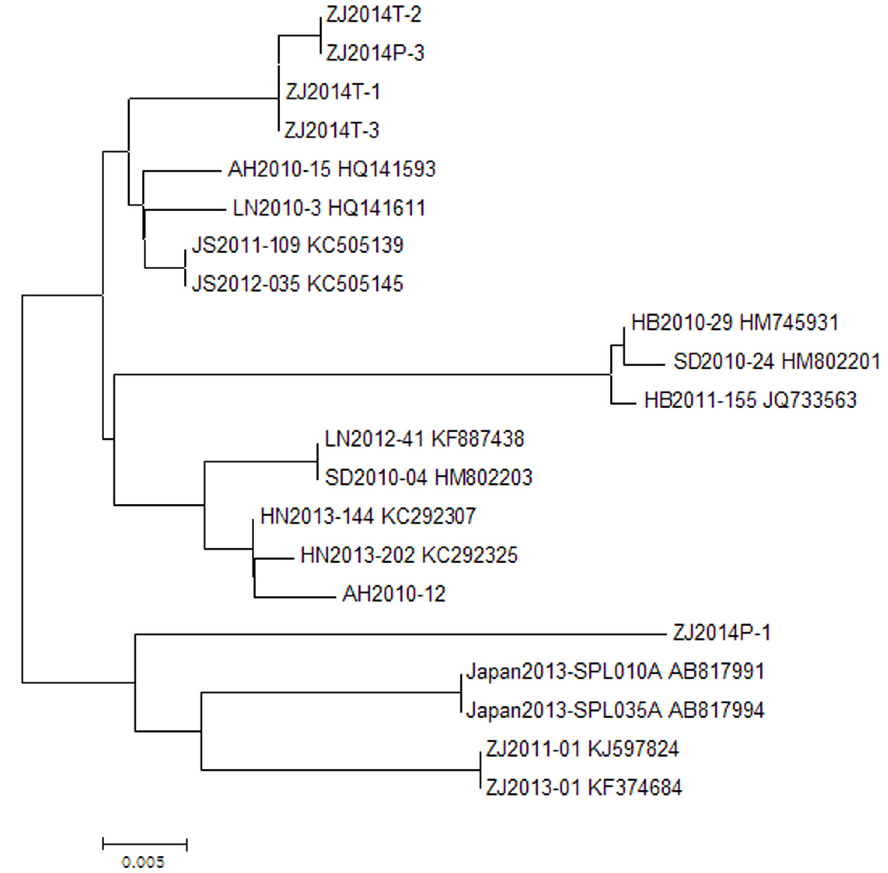
Fig 2. Phylogenetic analyses of SFTSV M genomic segments identified in patients and